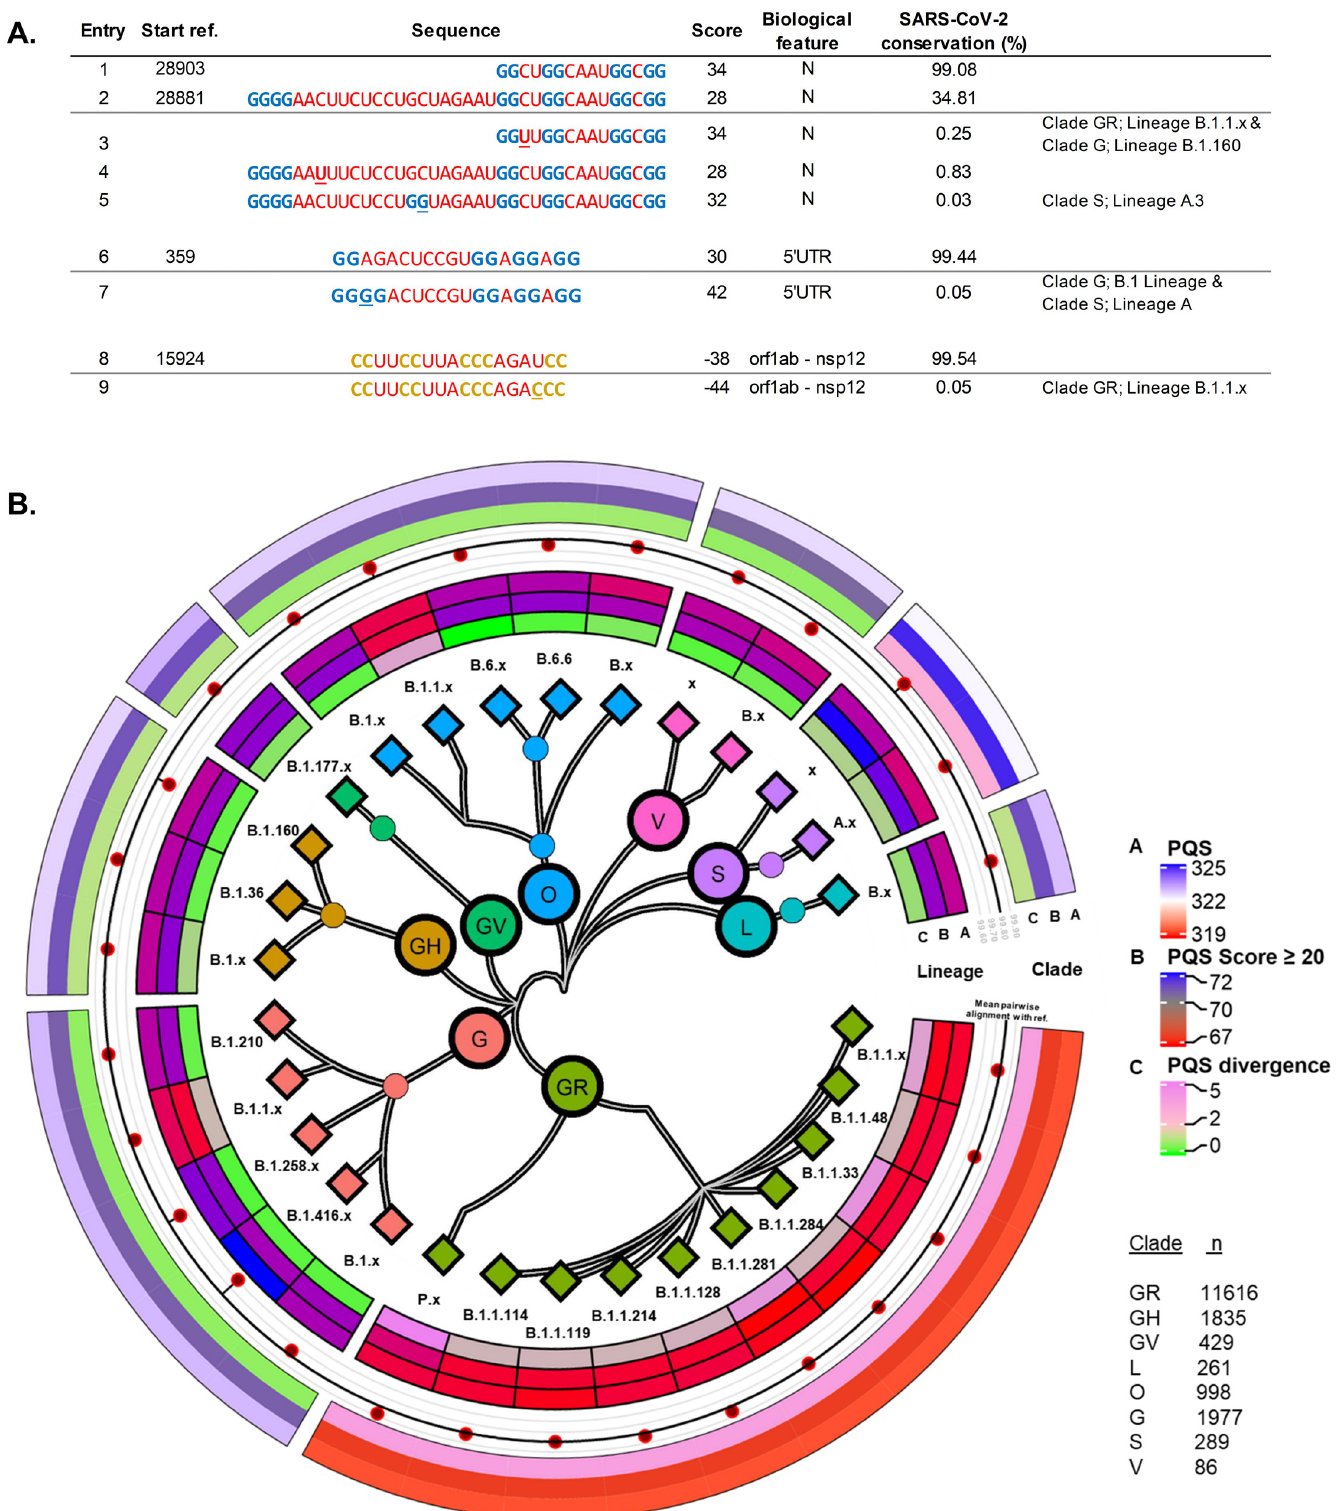
Fig 3. A . Sequences found in the SARS-CoV-2 reference genome (those with a starting position) and some of the variants identified in specific lineages for four high scoring candidates. Mutations are underlined. B . Centre, SARS-CoV-2 phylogenetic tree by clade and lineage of the sequences analysed. Lineages with less than 100